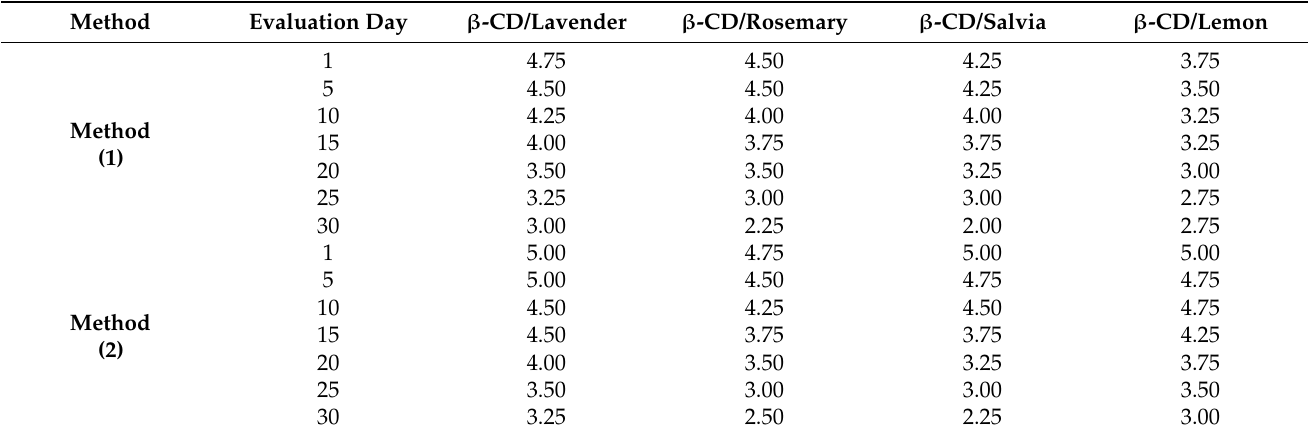
Table 2. Scent intensity of treated cotton fabrics with inclusion complex β -CD-EOs via methods 1 and 2 rating by judges.